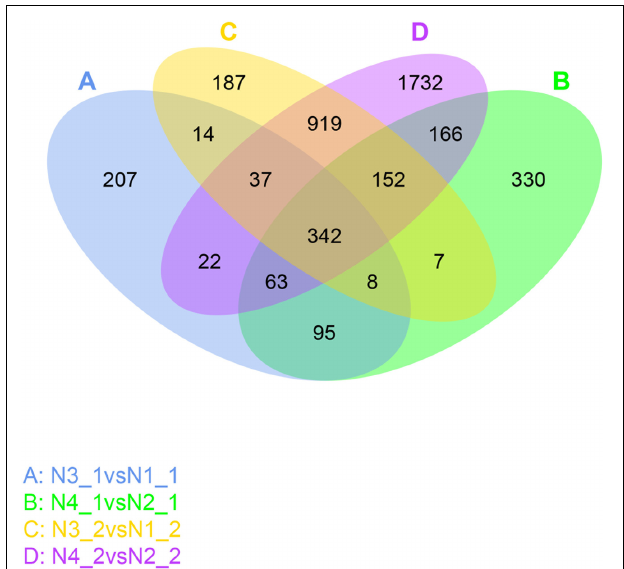
FIGURE 6 | Venn diagram describing the exclusion and overlap of regulated genes after GR24 treatment under salinity stress. The “N3_1 vs N1_1” (A) indicates a comparison between the gene expression in the N3_1 library with that in the N1_1 library, and the same describes the other labels (B–D) .